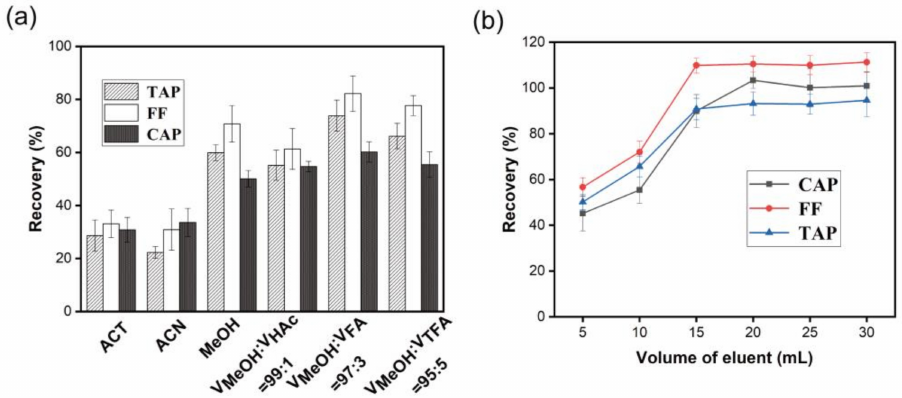
Figure 2. Optimization of SPE conditions. ACT: Acetone; ACN: Acetonitrile; MeOH: Methanol; HAc: Acetic acid; FA: Formic acid; TFA: Trifluoroacetic acid. ( a ) Effect of types of eluent on recovery ( n = 3). Conditions: Concentration of analytes, 5 ng/mL; Sample volume, 10 mL; Flow velocity, 1 mL/min; Sample pH, 6; Sample salinity, 0. ( b ) Effect of volume of eluent on recovery ( n = 3). Conditions: Concentration of analytes, 5 ng/mL; V MeOH /V FA , 97:3; Flow velocity, 1 mL/min; Sample pH, 6; Sample salinity, 0.